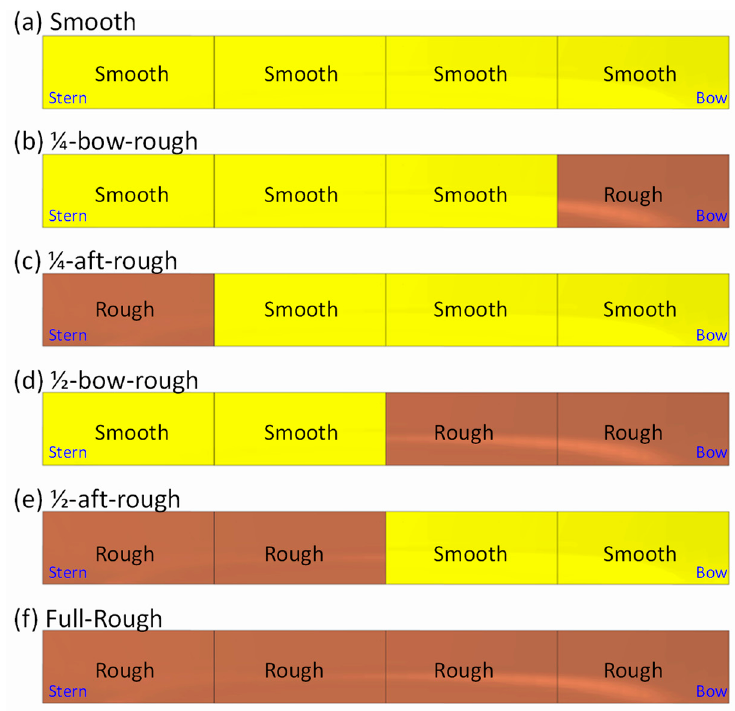
Figure 3. Different hull conditions of the Wigley hull simulations.